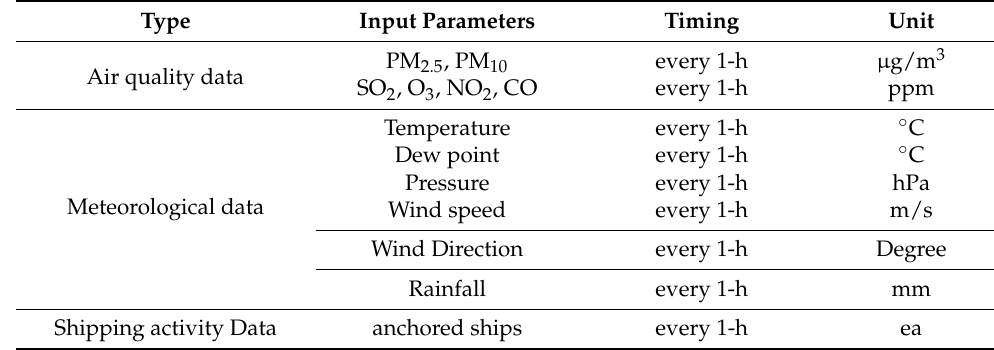
Table 3. Detailed information about input parameters in the input dataset of